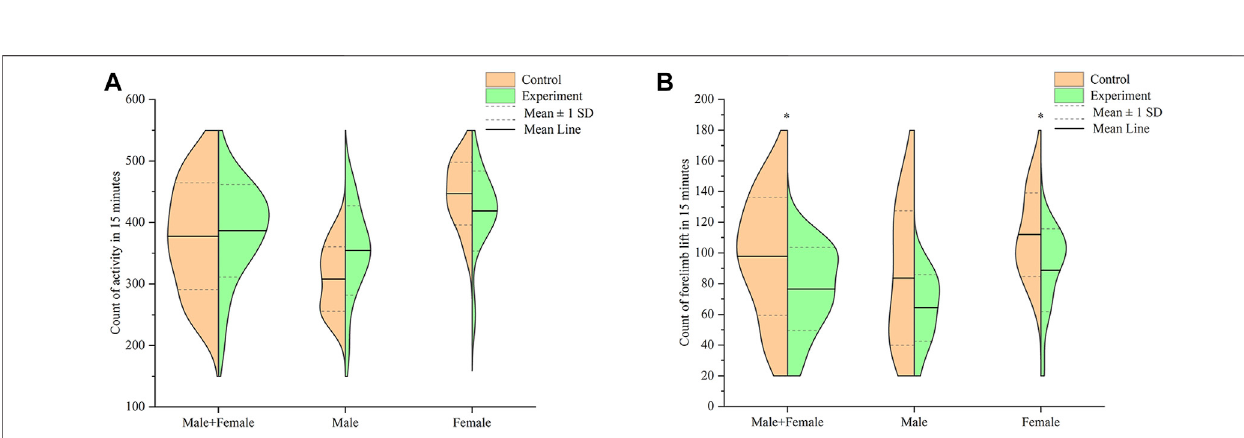
Figure 4 . There were signi fi cant differences in activity, chronic in fl ammation and atrophy scores between the experimental group and the control group. Due to the small quantity and mild degree of intestinal metaplasia and dysplasia, there was no signi fi cant difference, except for male mice in intestinal metaplasia. In the experimental group, there was no signi fi cant difference in the above pathological scores between male and female mice. These pathological changes indicated successful establishment of a Hp-associated chronic gastritis mouse model.